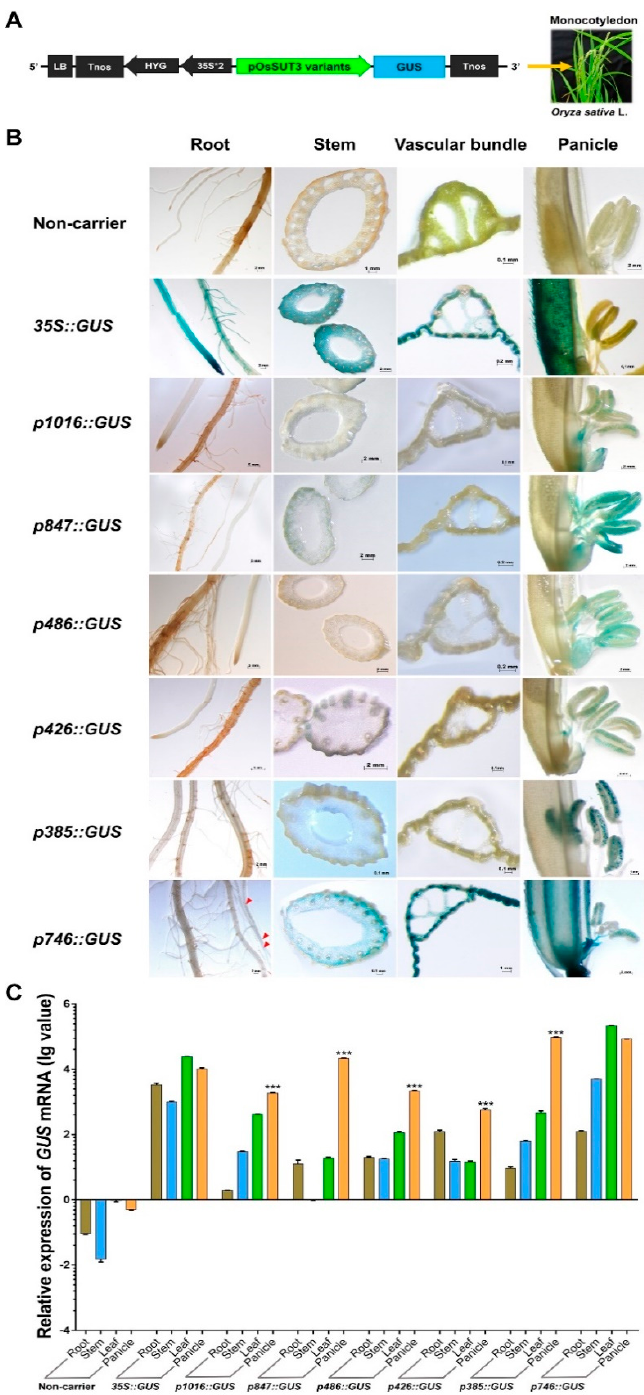
Figure 2. GUS expression in various rice transformants and non-carrier plants. ( A ) Linear map of different pOsSUT3 variants for transgenic rice. ( B ) Histochemical localization of GUS activity in vegetative tissues from stably transformed rice plants. The columns from left to right indicate the root, stem, leaf, and panicle. The lines from top to bottom indicate the tissues from non-carrier, 35S, p1016, p847, p486, p426, p358, and p746 lines. The red arrows of p746 staining root indicate GUS activity. ( C ) The relative GUS transcript expression assayed by qRT-PCR in the root, stem, leaf, and panicle harvested from p1016, p847, p486, p426, p358, and p746 rice transformants compared to non-carrier plants and 35S:: GUS transgenic lines. Brown bar chart: root; blue bar chart: stem; green bar chart: leaf; orange bar chart: panicle. Data are shown as the mean ± SD ( n = 3), student’s t -test. *** represents highly significant differences from all tested tissues from each transgenic plant. Relative expression was calculated as: lg2 −ΔΔ Ct .